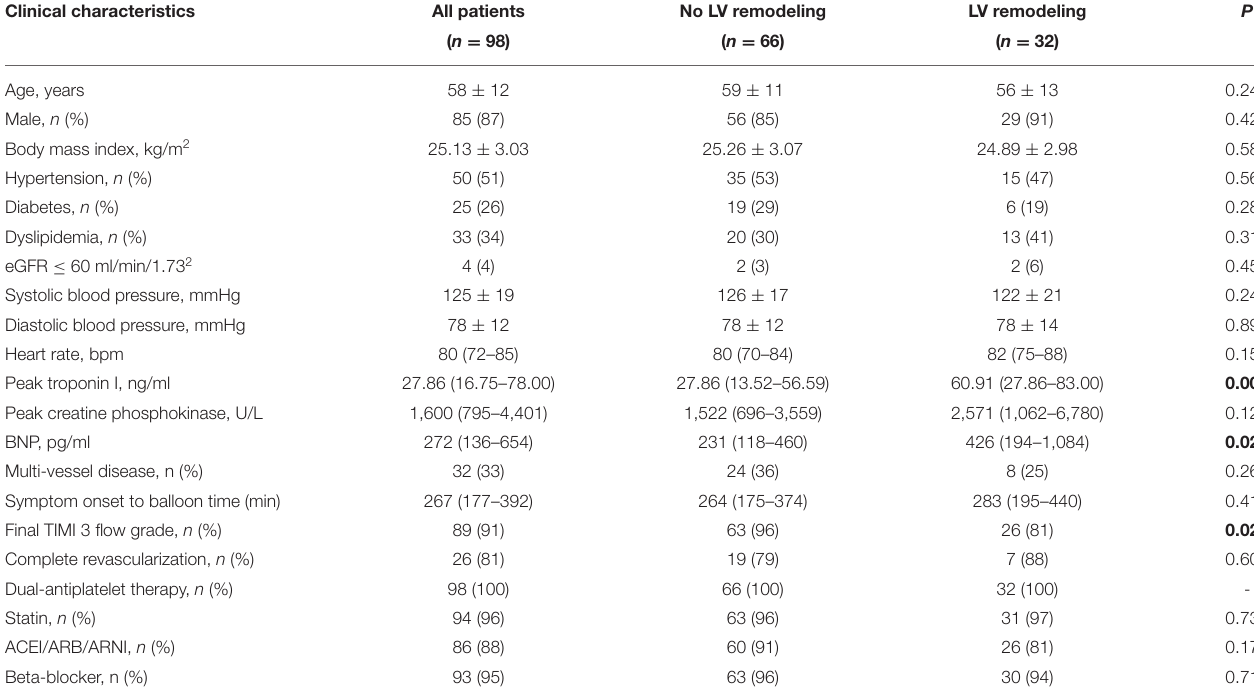
TABLE 1 | Baseline characteristics of the study